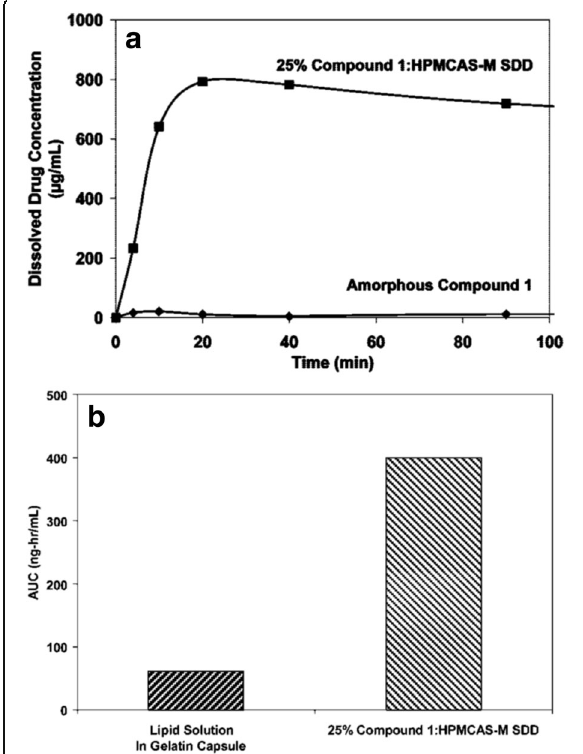
Fig. 13 The “ spring and parachute ” in vitro dissolution profile (top panel a ) enables in vivo bioavailability enhancement (bottom panel b ) (Adapted from Friesen et al.